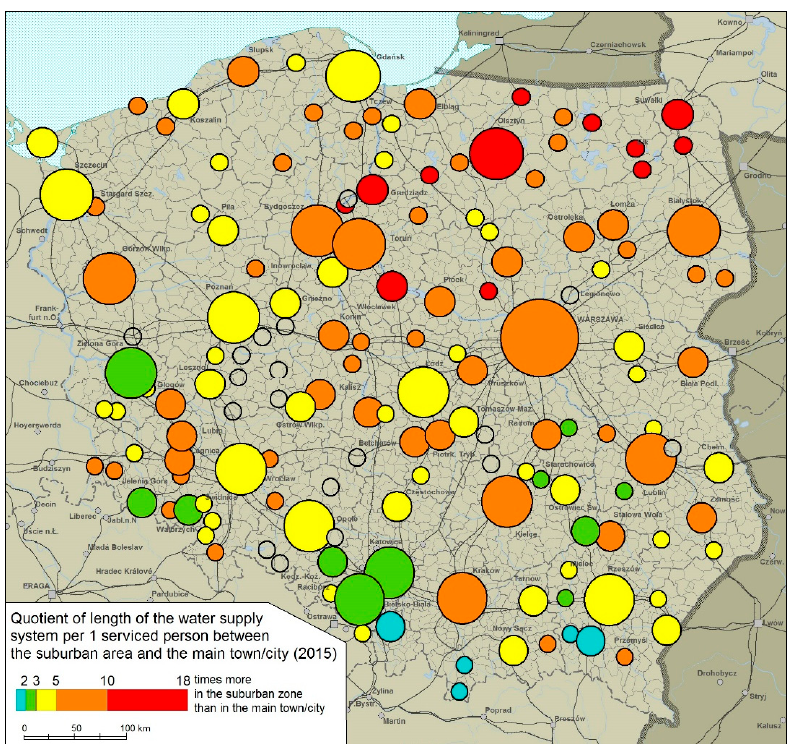
Figure 3. Indicator comparing the e ff ectiveness of the water supply network in cities and their suburban areas. The higher the multiplicity, the e ffi ciency of suburban areas is correspondingly lower than in the main city. Source: